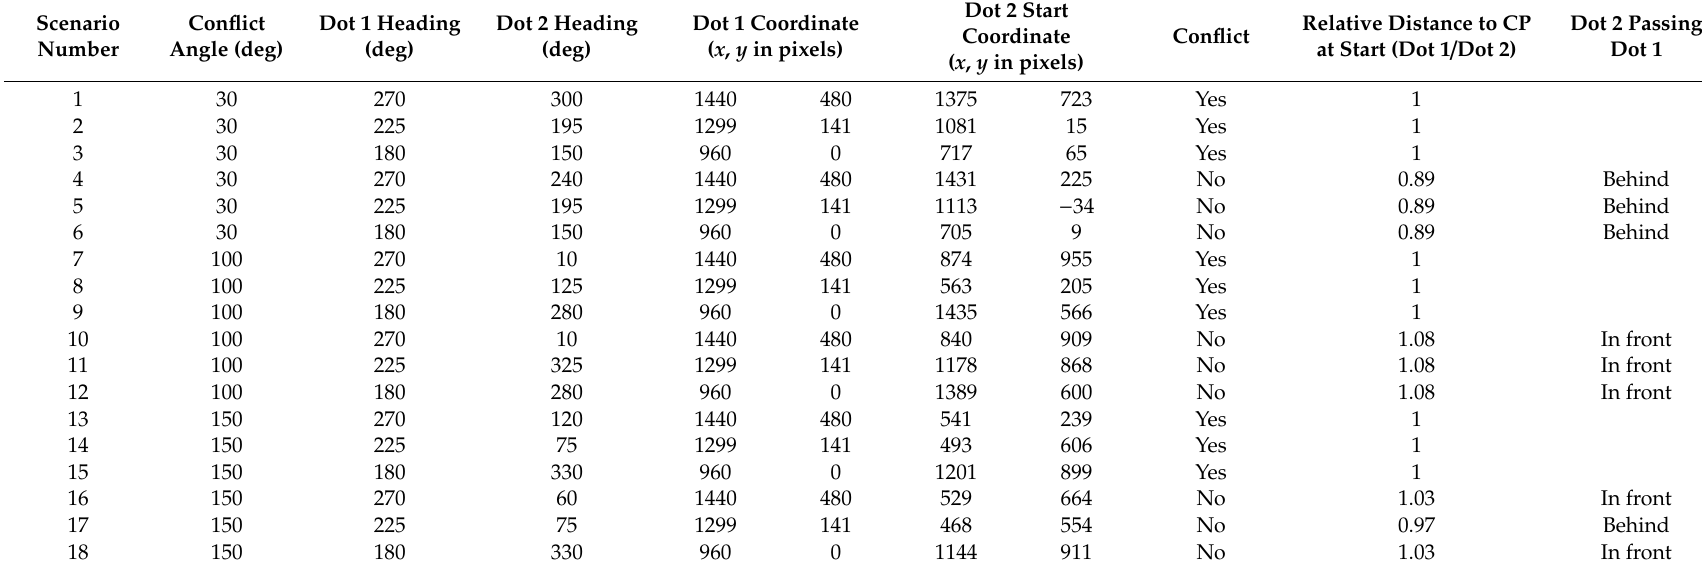
Table 1. Characteristics of Scenarios